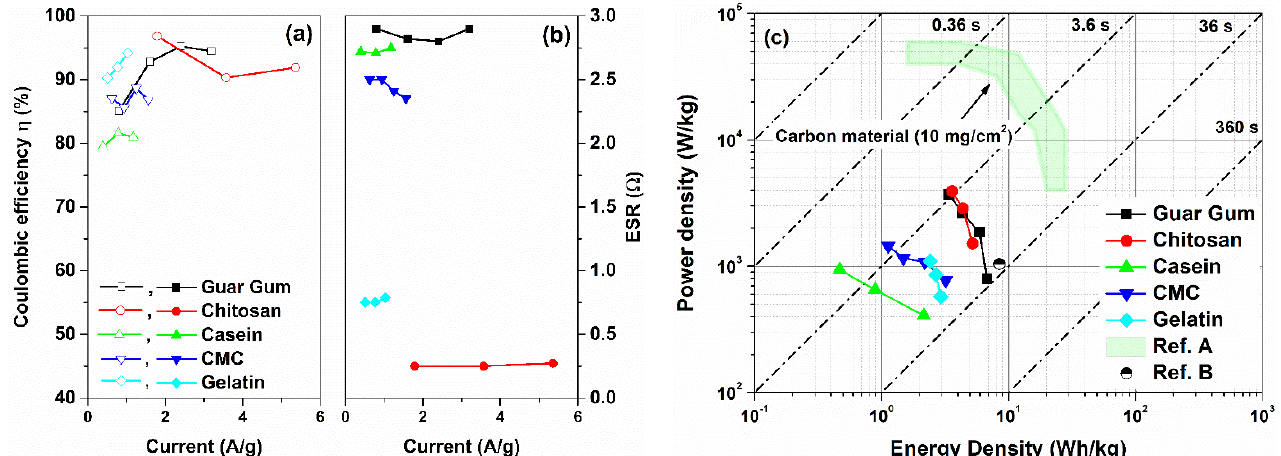
Figure 7. Current dependence of the ( a ) Coulombic efficiency and ( b ) equivalent series resistance values as a function the binders investigated, respectively; ( c ) Ragone plot of gravimetric power density versus gravimetric energy density for the investigated electrodes in comparison with other reported symmetric environmentally friendly aqueous carbon-based SCs with their associated time constant regimes. The references [A] and [B] correspond to [45,46], respectively.